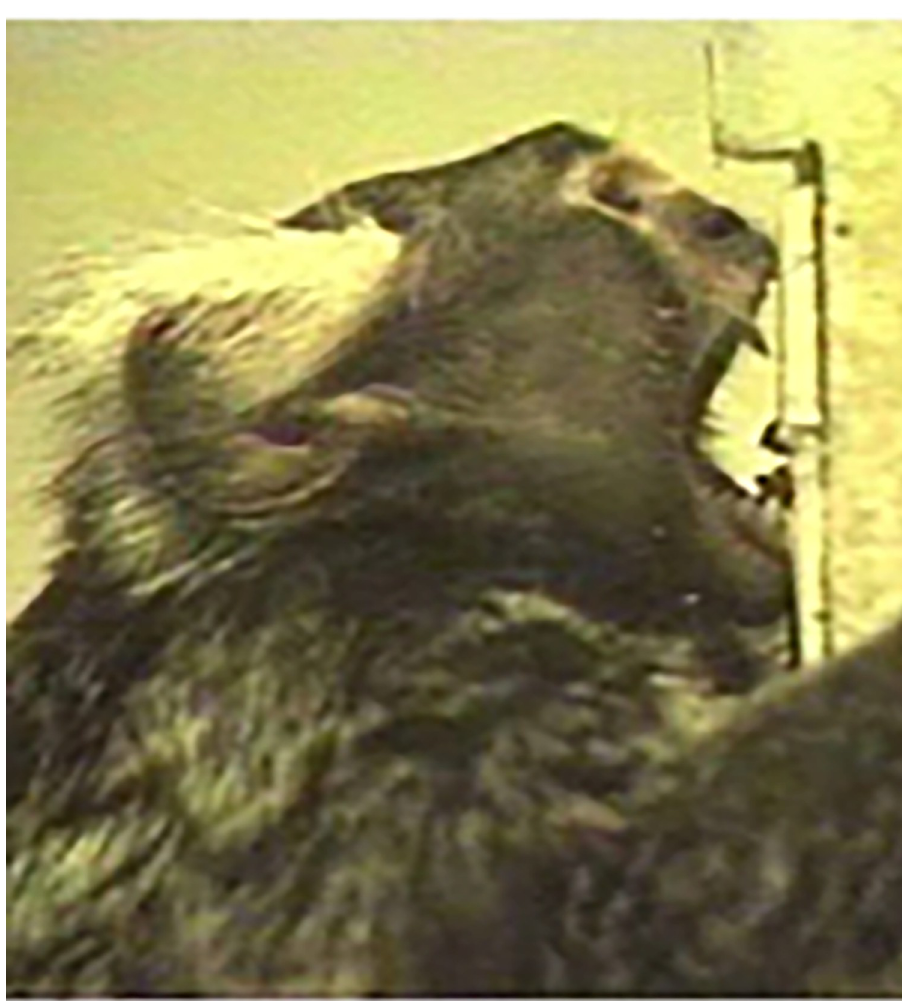
Fig 19. Tree gouging action with AU27—Mouth Stretch at its apex (adapted from